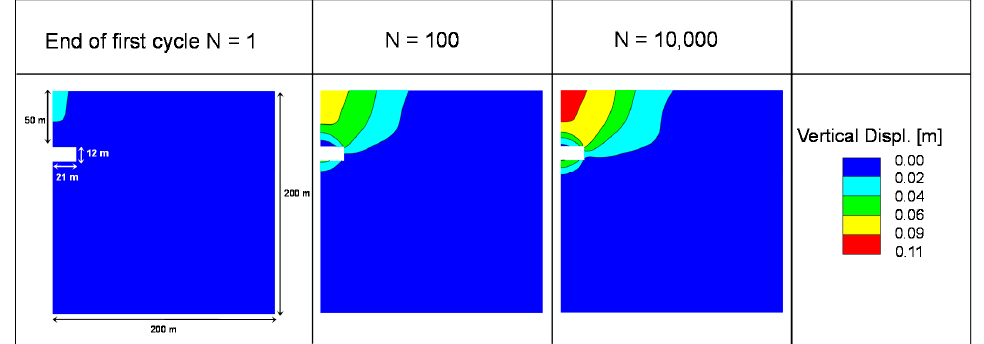
Figure 5. Redistribution of displacements fields evolved by cyclic internal stress around the surface elements along the unlined storage at cycles N = 1, 100, and 10,000. The case location z o = 50 m, storage width w = 21 m, and cyclic internal stress amplitude Δ P / P avg = 15%.